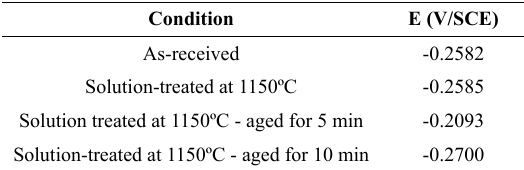
Table 3. Open circuit potential of UNS S32520 SDSS in 3.5% NaCl solution at 25ºC